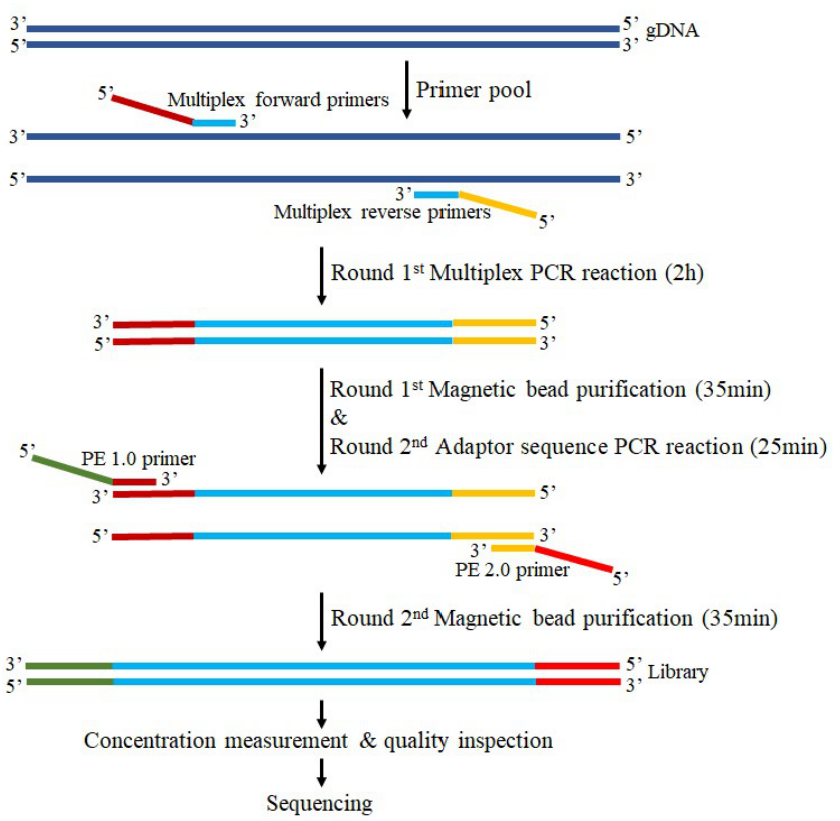
Figure 1. Library construction and capture workflow of the multiple polymerase chain reaction (multi-PCR). All samples followed the standard sequencing workflow with a total time course of 3 h 35 min.